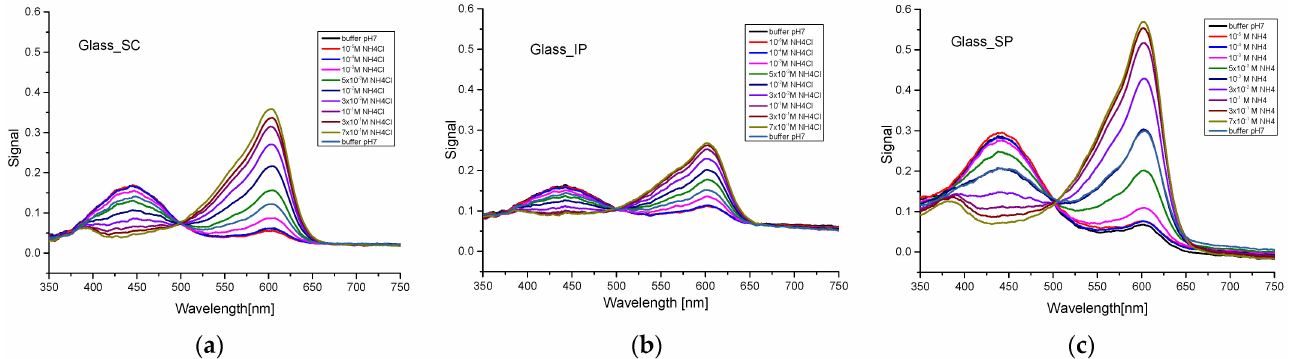
Figure 5. Spectral properties of sensor layers (SC, IP, SP) in the presence of dissolved NH 3 . ( a ) Glass_SC, ( b ) Glass_IP, ( c ) Glass_SP.